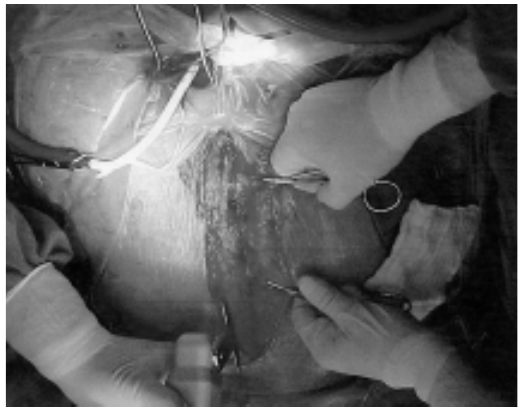
Fig. 2 - Perfusion by the right carotid artery through the PTFE tube connected to the arterial line of the cardiopulmonary bypass. Sternotomy when the temperature of the patient reaches 20 ºC.